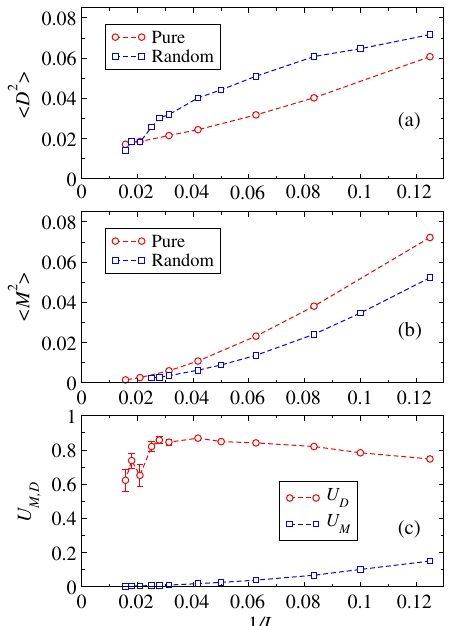
FIG. 14. VBS (a) and AFM (b) order parameters and the corresponding Binder cumulants (c) versus the inverse system size for the model with bimodal J couplings (50% each of J ¼ 0 and J ¼ 1 ) at Q ¼ 2 . Results for the pure model with J ¼ 1 are shown for comparison in (a) and